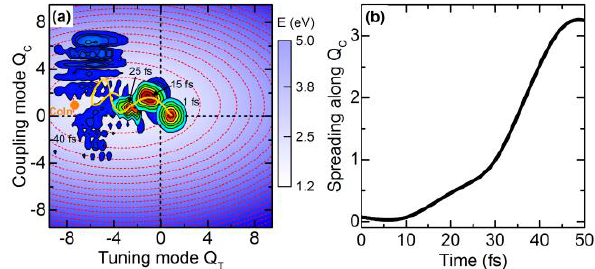
Fig. 2. Simulated wavepacket dynamics through a conical intersection based on a two-mode linear vibronic coupling model. (a) Snapshots of the simulated wavepacket dynamics projected on